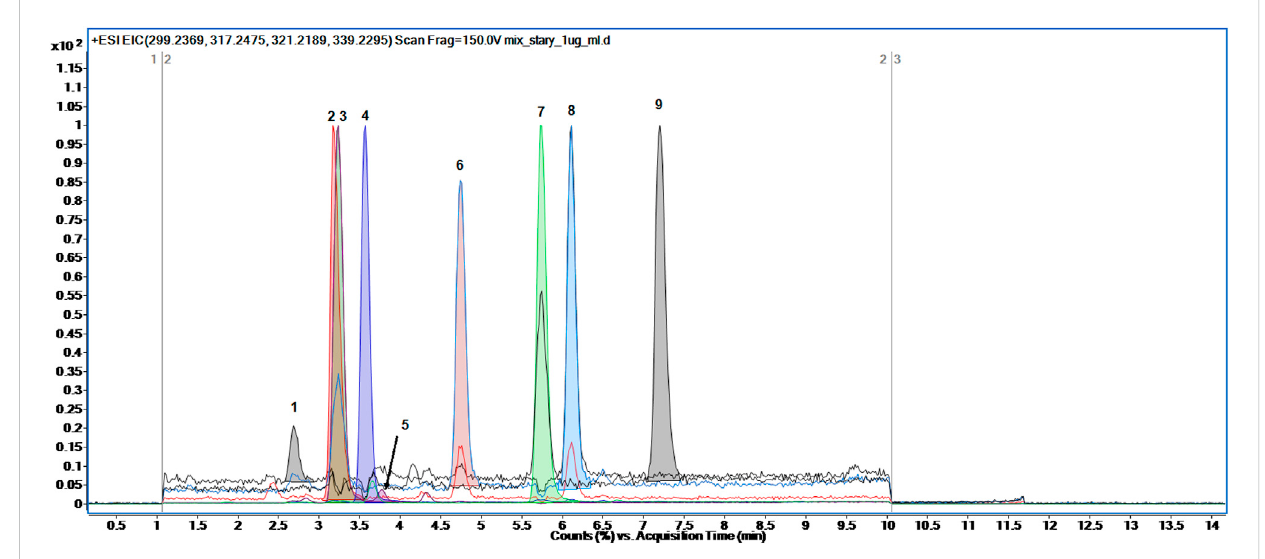
FIGURE 2 TherepresentativeTotalIonChromatogram(TIC)ofeightsteroidhormonesalongwithinternalstandarddetectedinfullscanmode:one-estradiol, 2-d3-testosterone, 3-testosterone, 4-17 α -hydroxyprogesterone, 5-DHEA, 6-DHT, 7-progesterone, 8-androsterone,